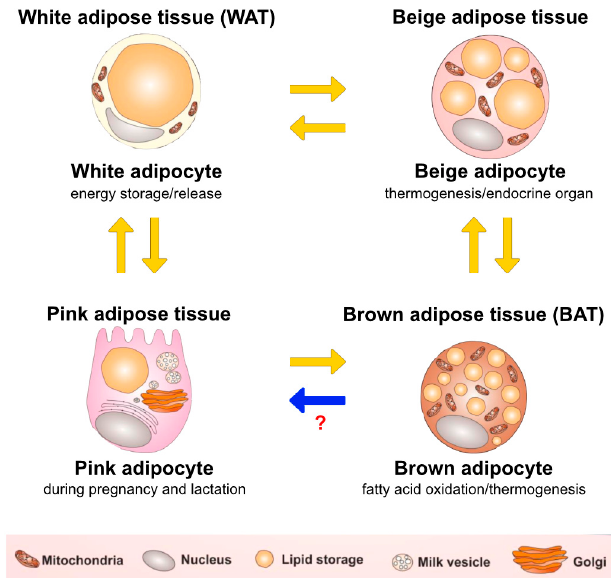
Figure 1. The conversion between adipocytes. Yellow arrows: white-brown-white adipocytes transdifferentiation, white-to-pink transdifferentiation, pink-to-brown transdifferentiation ( blue